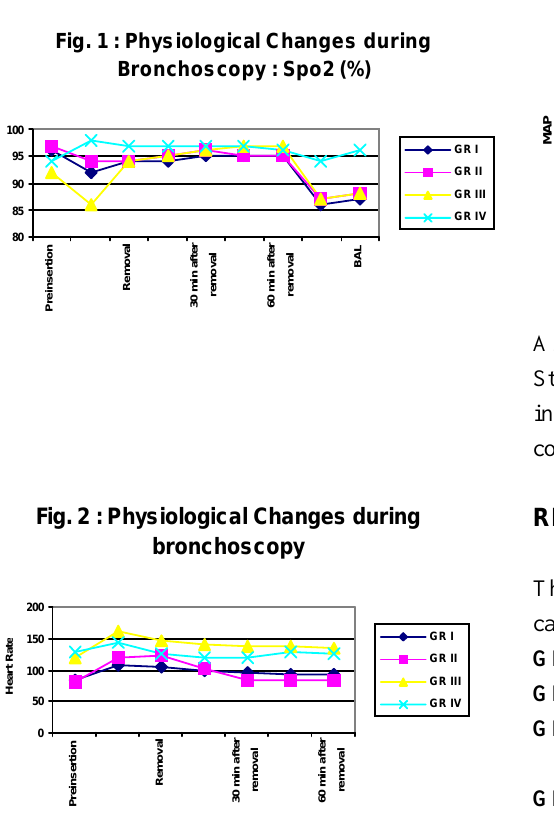
Fig. 3 : Physiological Changes During Bronchoscopy : MAP